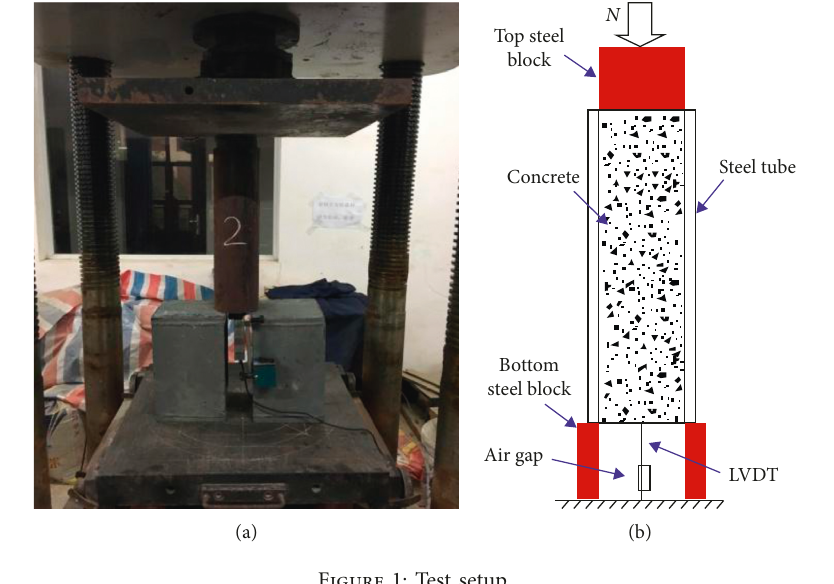
Figure 1: Test setup.